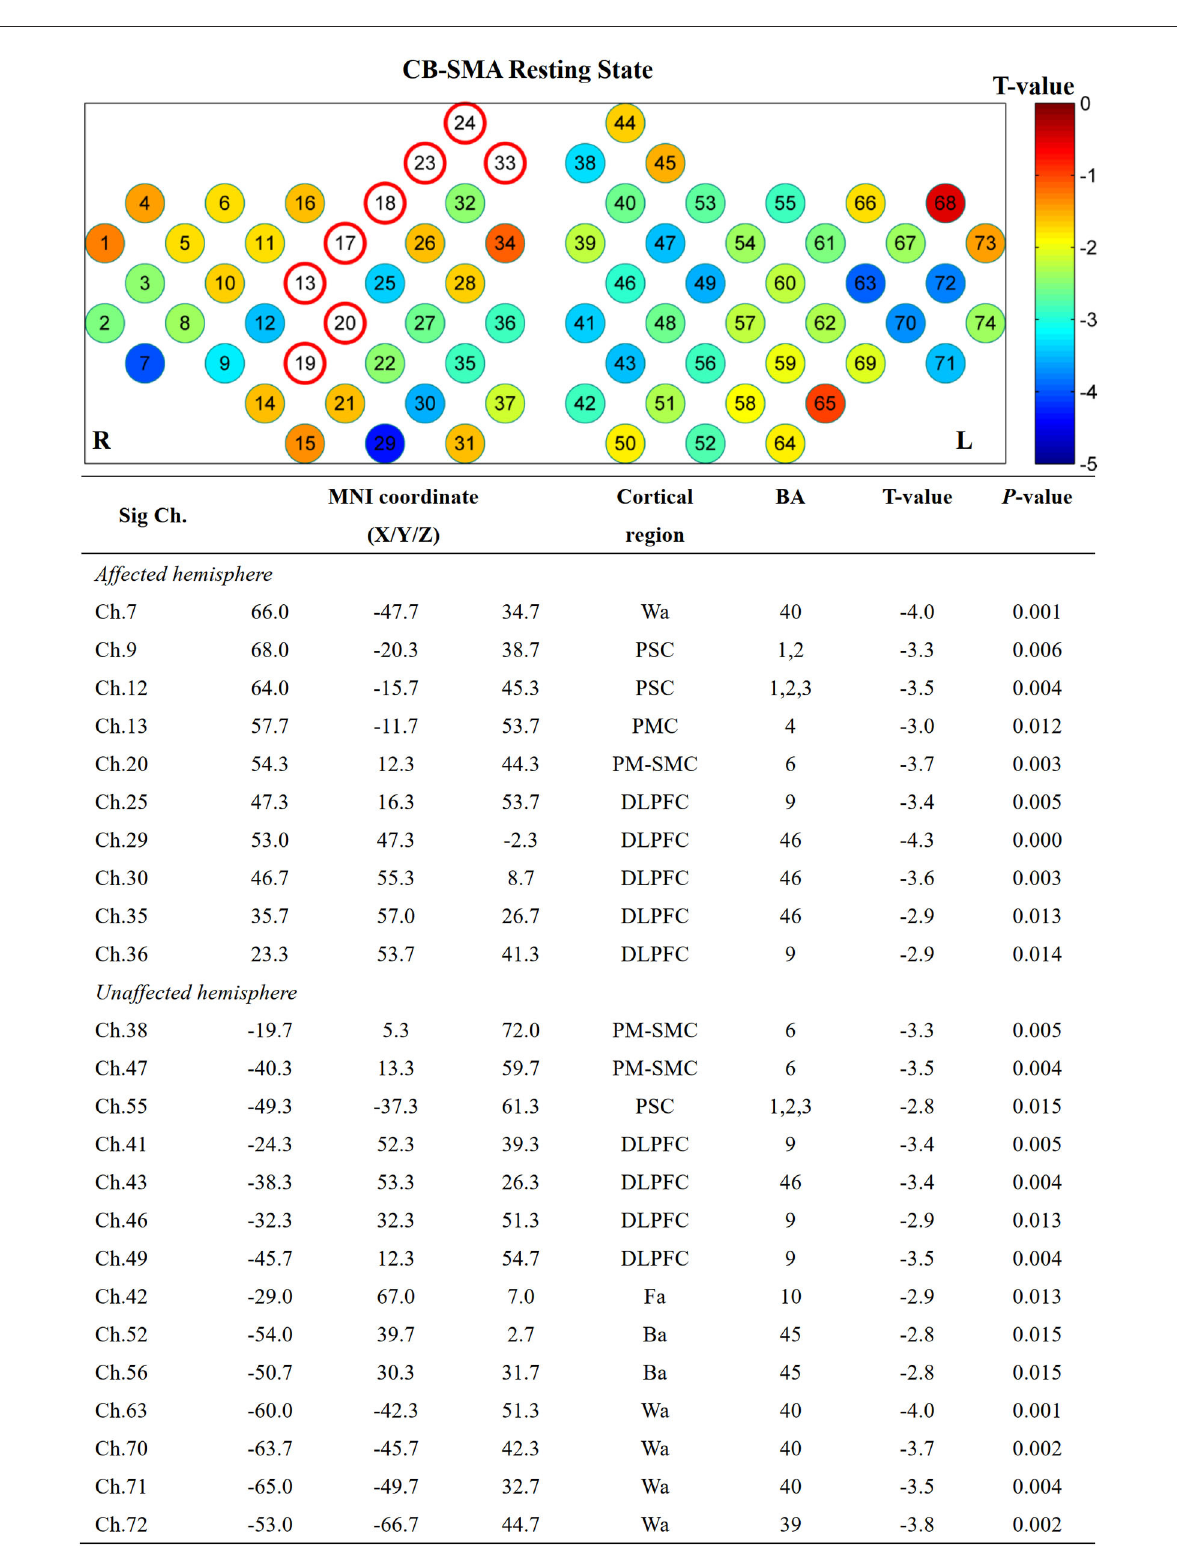
FIGURE5 Significant channels after iTBS intervention with their MNI coordinate, Brodmann’s label, T - and P- value. Wa, Wernicke’s area; Ba, Broca’s area; PSC, Primary somatosensory cortex; PMC, Primary motor cortex; PMSMC, Pre-Motor and supplementary motor cortex; DLPFC, Dorsolateral prefrontal cortex; Fa, Frontopolar